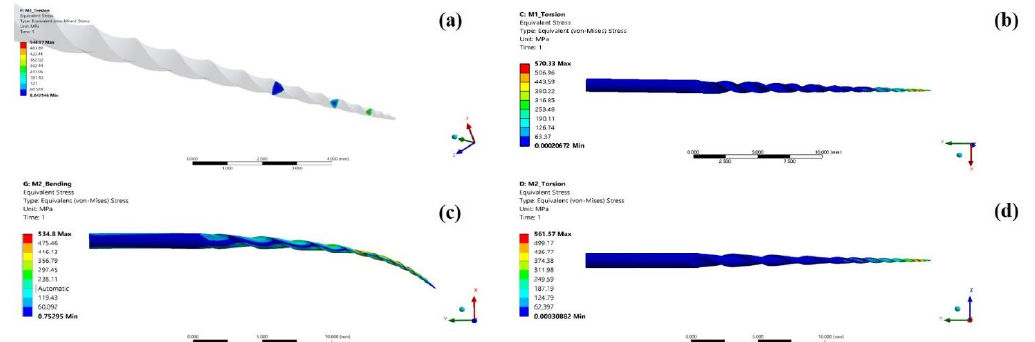
Fig. 6. Distribute torsion stresses in the a) Vortex blue file (file length view), b) Hyflex EDM file (longitudinal view of the file), c) in the One Curve file (longitudinal view of the file), and d) One Curve file (longitudinal view of the file).